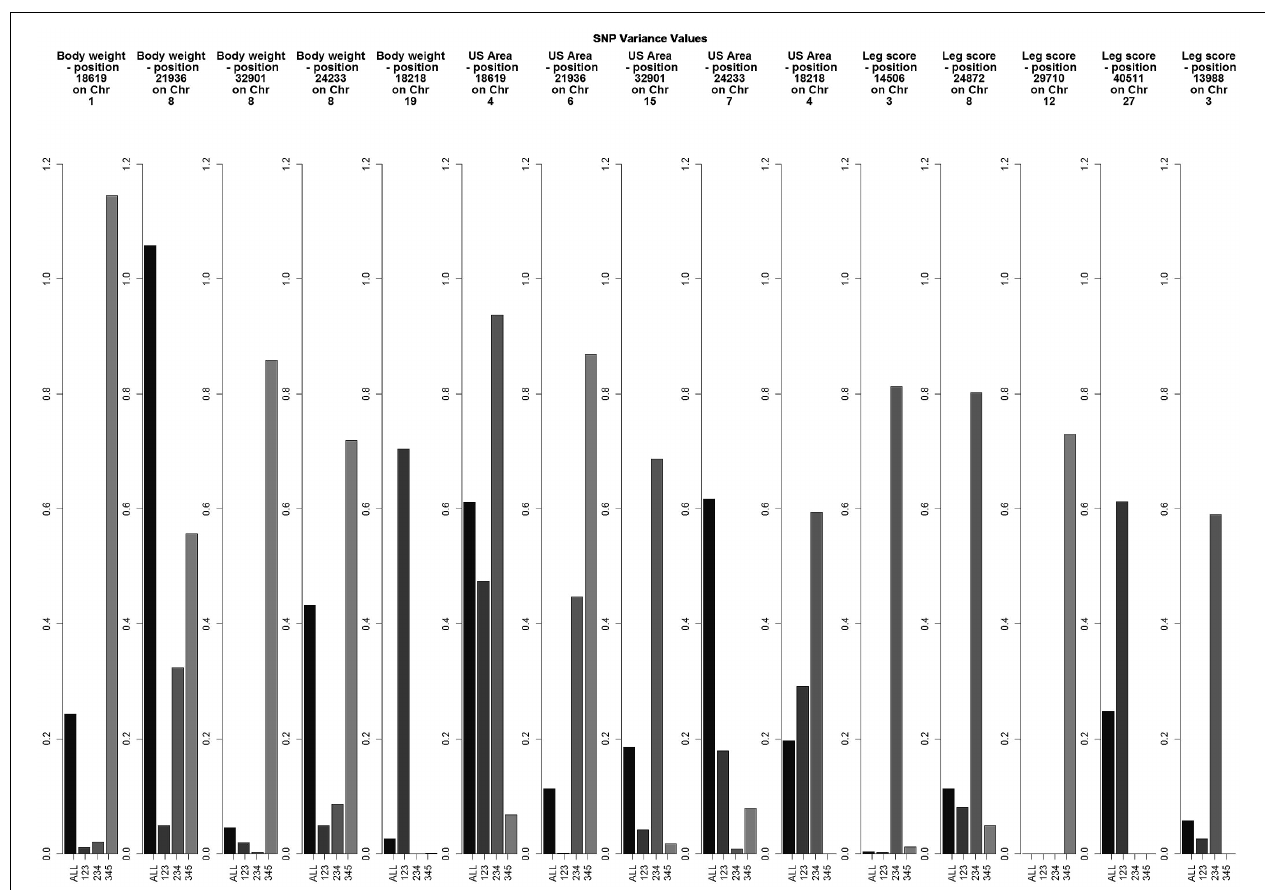
FIGURE 1 |Variance explained by the top five individual SNPs based on the combined results for all data sets for each trait.